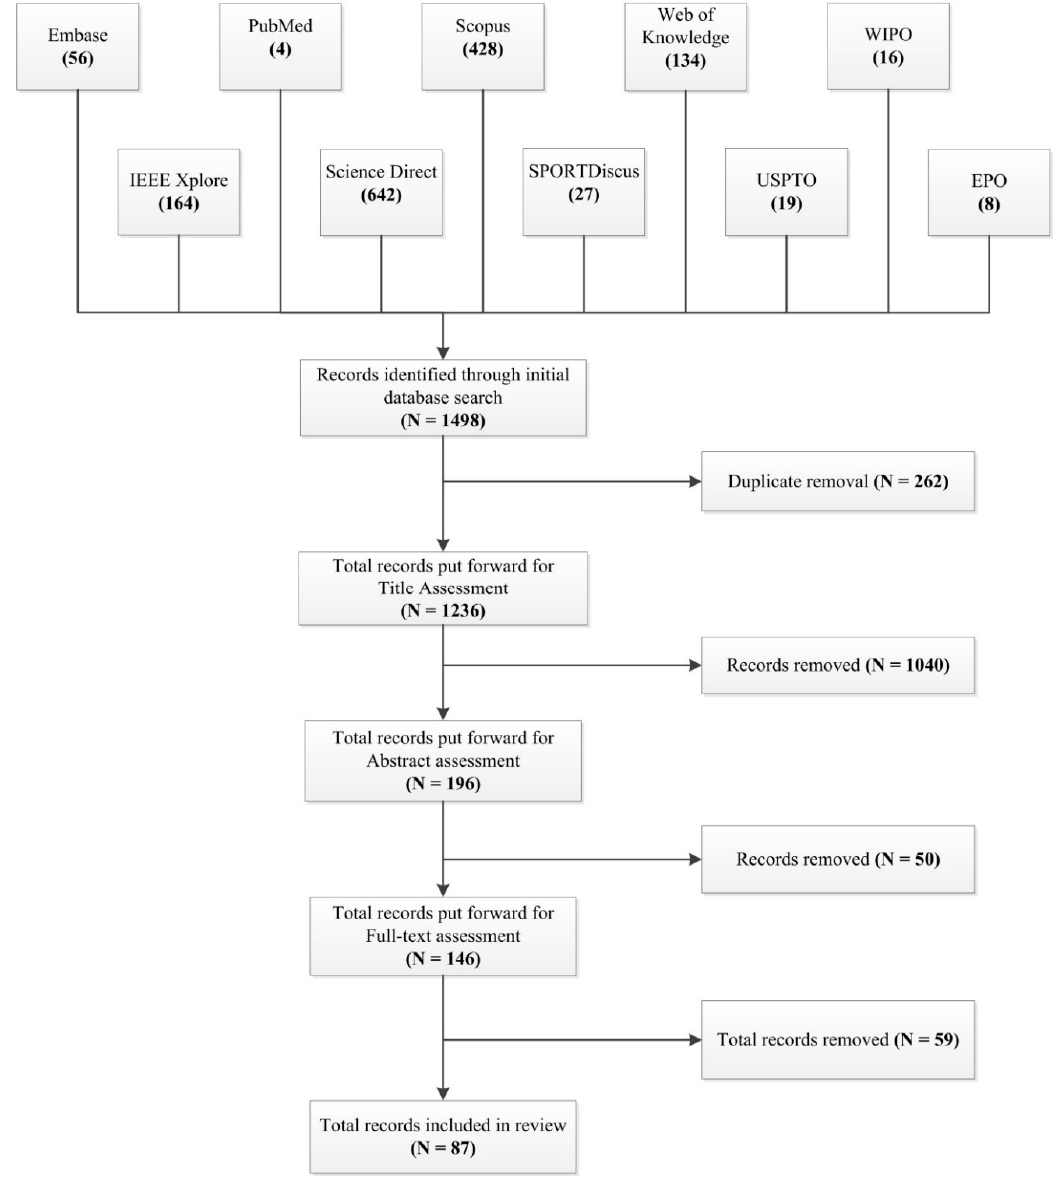
Figure 3. Systematic review search strategy and results.